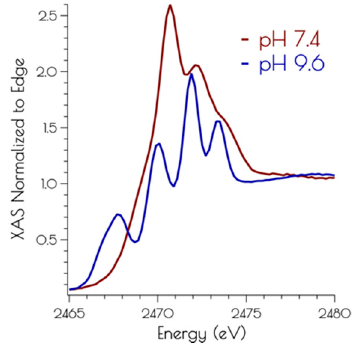
Figure 4. Sulfur K-edge XANES of {Ni 2II (SOD mds )} at high 7.4 (red) and 9.6 (blue).